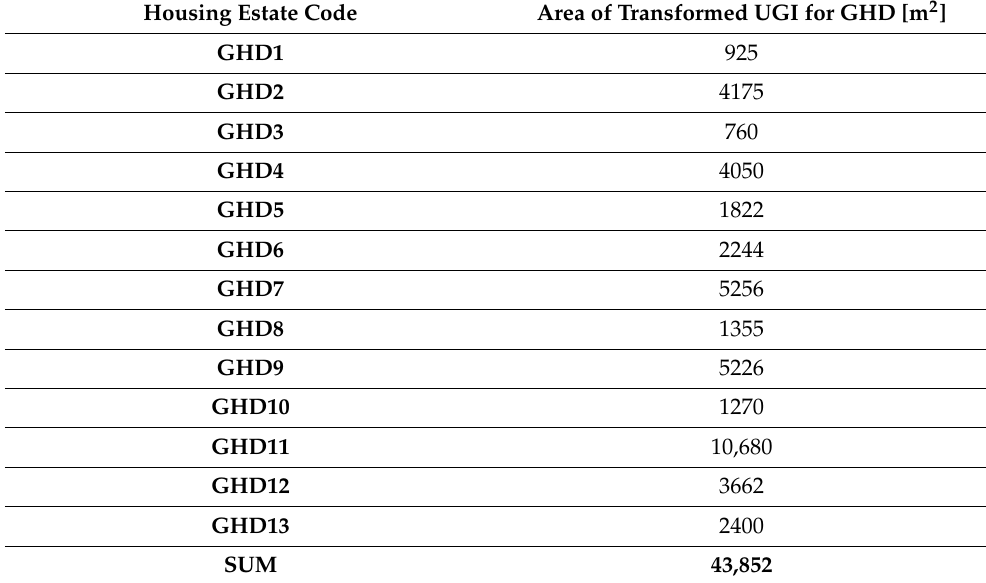
Table 1. Area of UGI transformed for GHD in Rzeszow (in m 2